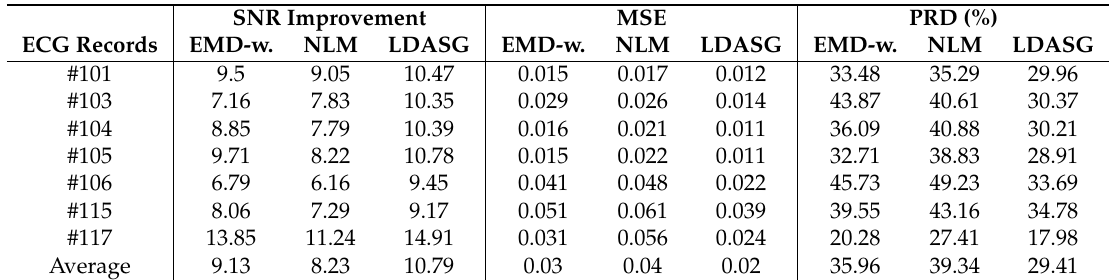
Table 1. Results of ECG denoising performance with the SNR level of 0 dB.